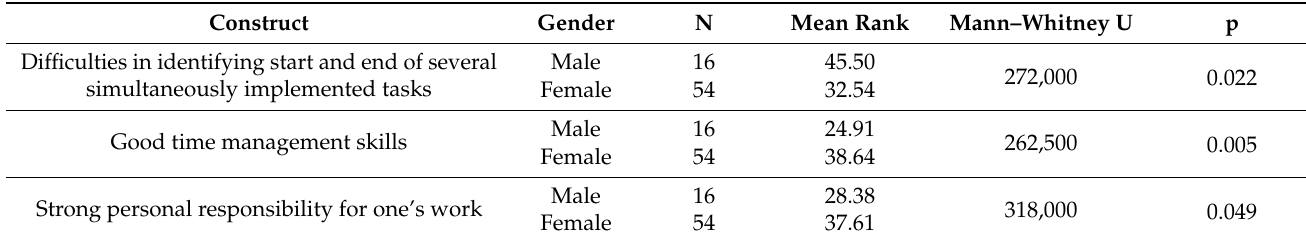
Table 7. The evaluation of teleworking between Xennial men and